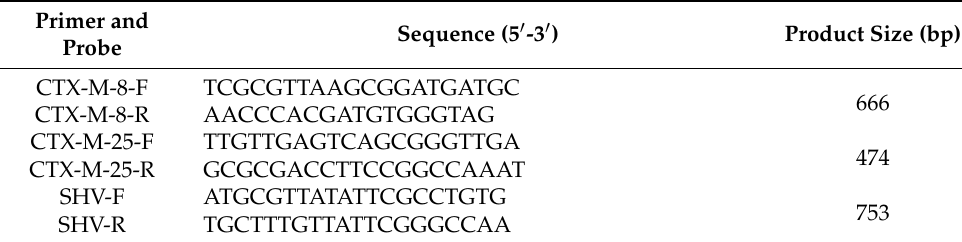
Table 1. Cont. Primer